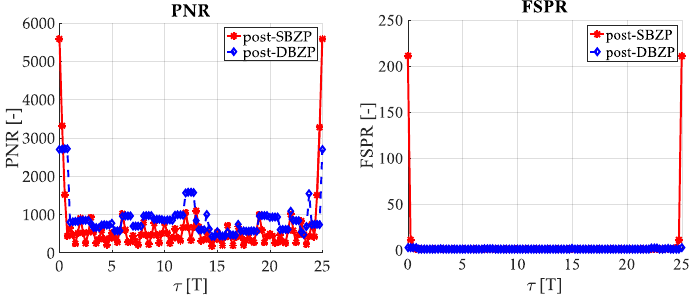
Figure 5. Result of the utilization of the single-step PCS post-correlation schema with SC (Galileo CS25 1 ) . CS25 1 ) .